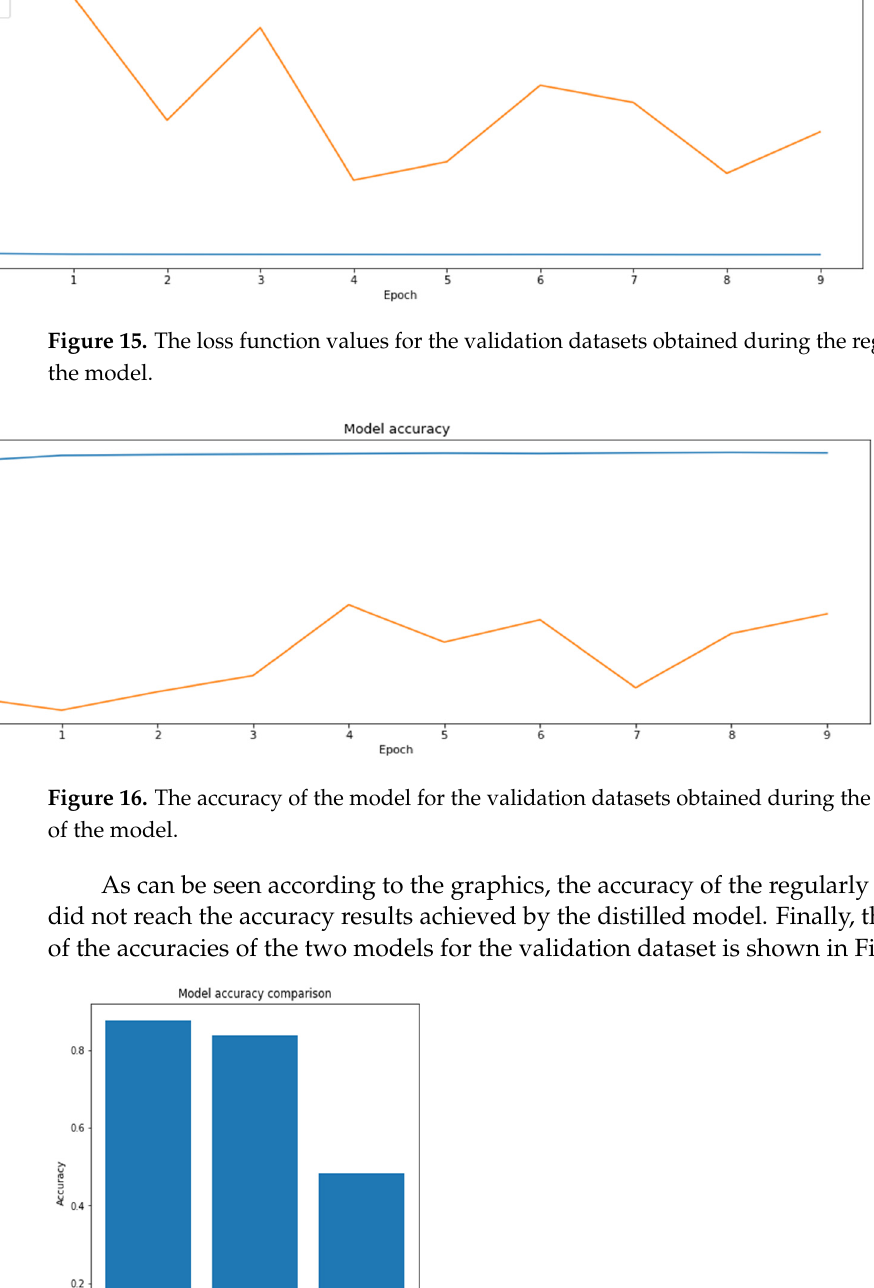
13 of 22 Figure 13. Training and the validation datasets obtained during the model distillation process. Figure 14. The accuracy of the model for the validation datasets obtained during the model distillation process.